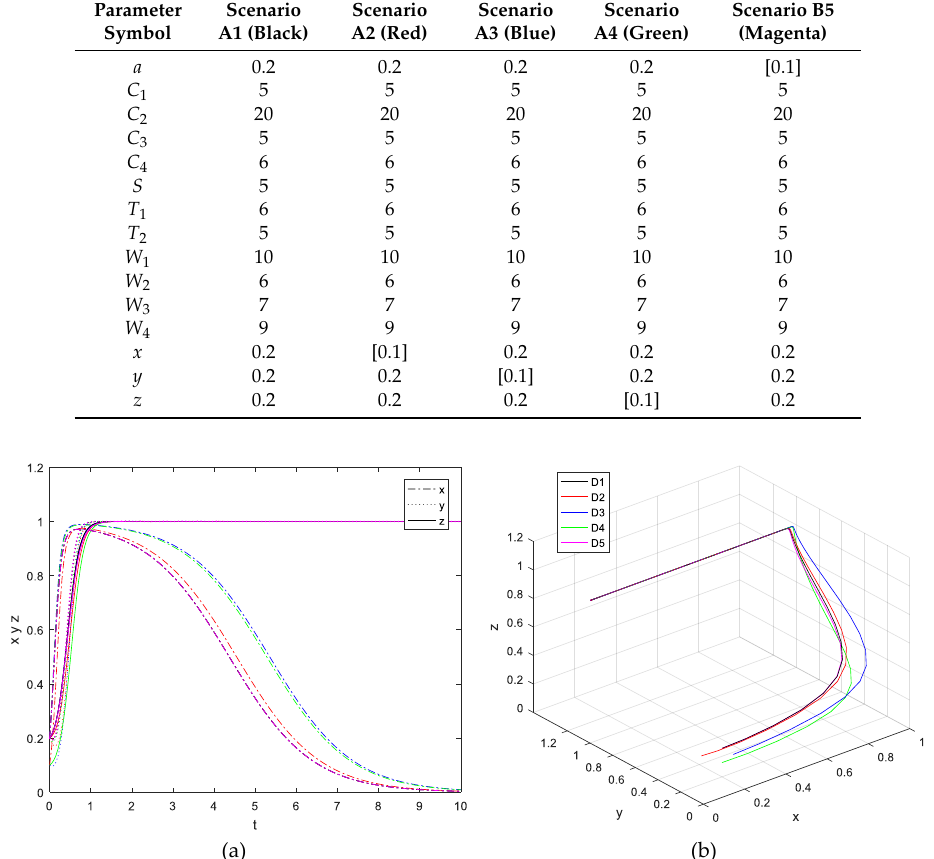
Table 7. Value of ideal scenario.